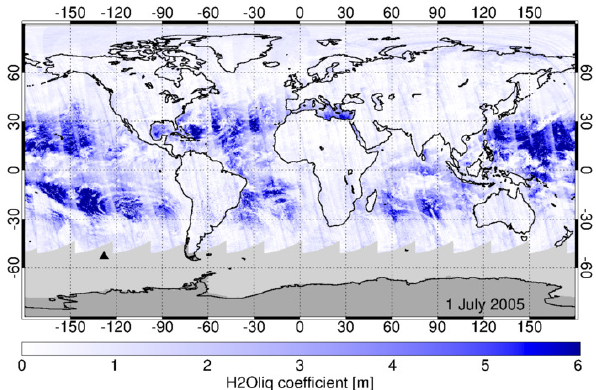
Figure 9. World map of the H 2 O liq coefficient (in m) based on all Fig.9. WorldmapoftheH 2 O liq coefficient(inm)basedonall15OMIorbitsof1July2005;thePacificOcean testorbitismarkedbyablacktriangle. Allgroundpixelswithsolarzenithanglelessthan 75 ◦ areplotted; no 15 OMI orbits of 1 July 2005; the Pacific Ocean test orbit is marked filteringforcloudypixelswasapplied. by a black triangle. All ground pixels with solar zenith angle less than 75 ◦ are plotted; no filtering for cloudy pixels was applied.